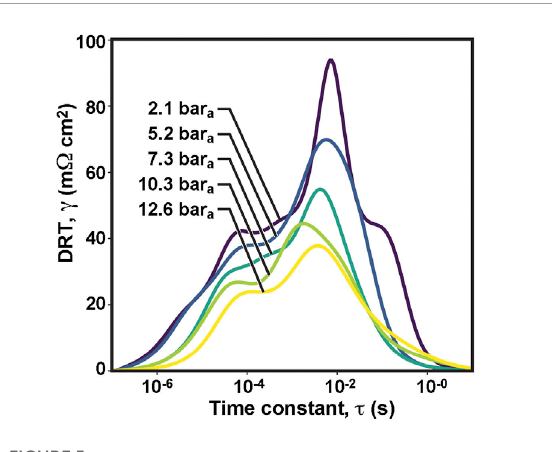
FIGURE 5 Effect of pressure on distribution of relaxation times in protonic-ceramic electrolyzer at open-circuit